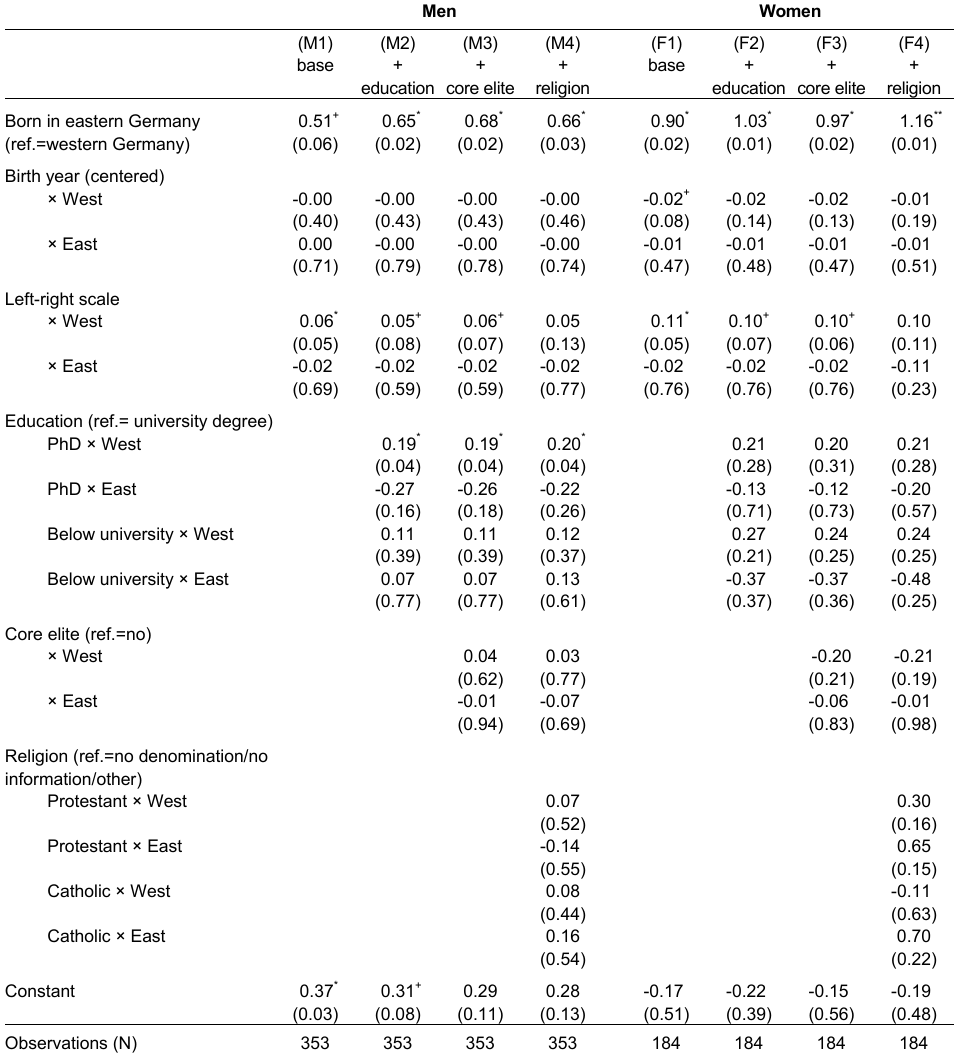
Multivariate negative binomial regression